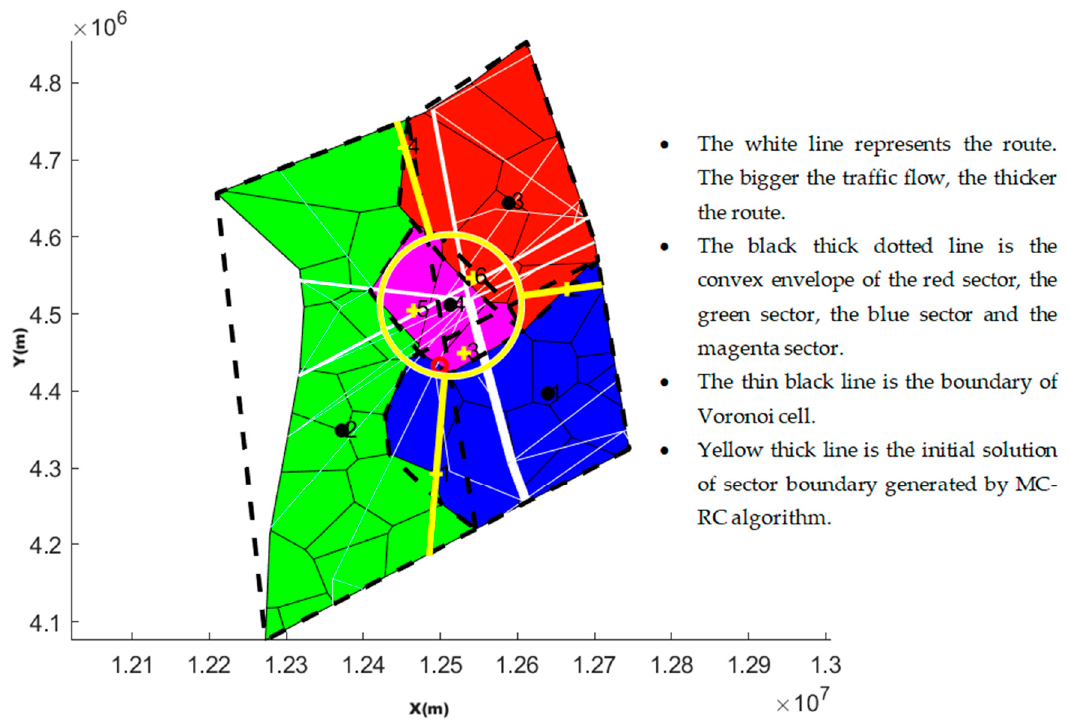
Figure 12. Initializing hub and spoke.